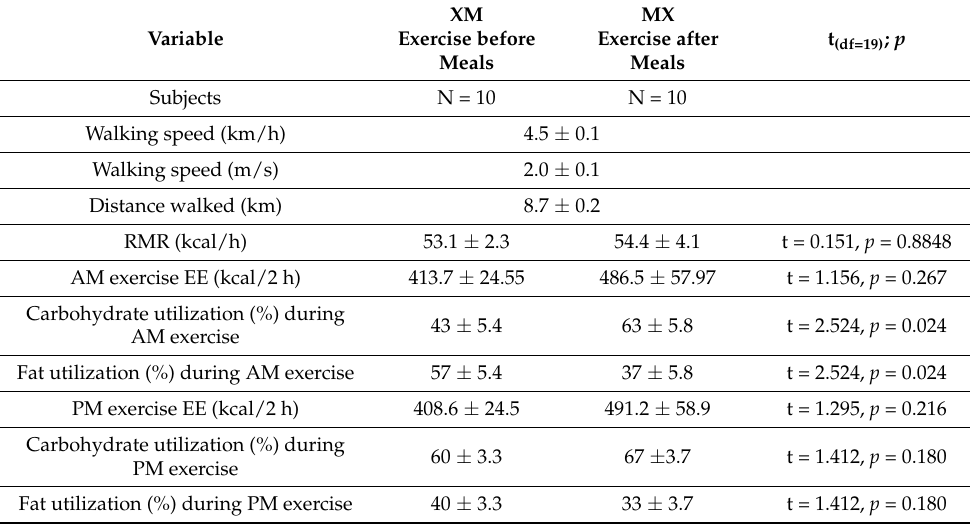
Table 4. Characteristics and metabolic effects of